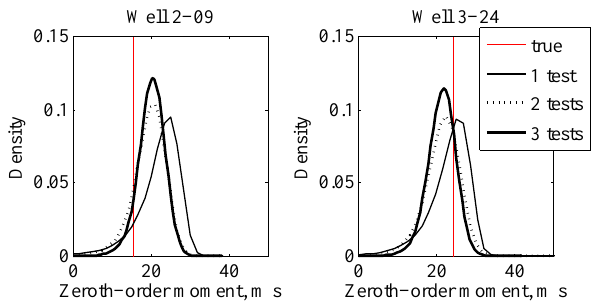
Fig. 8. Comparison between the zeroth-order moments observed at Well 2-09 and 3-24 in the injection test at Well 2-18, and predictive posterior distributions from the inversion, including the different numbers of injection tests.